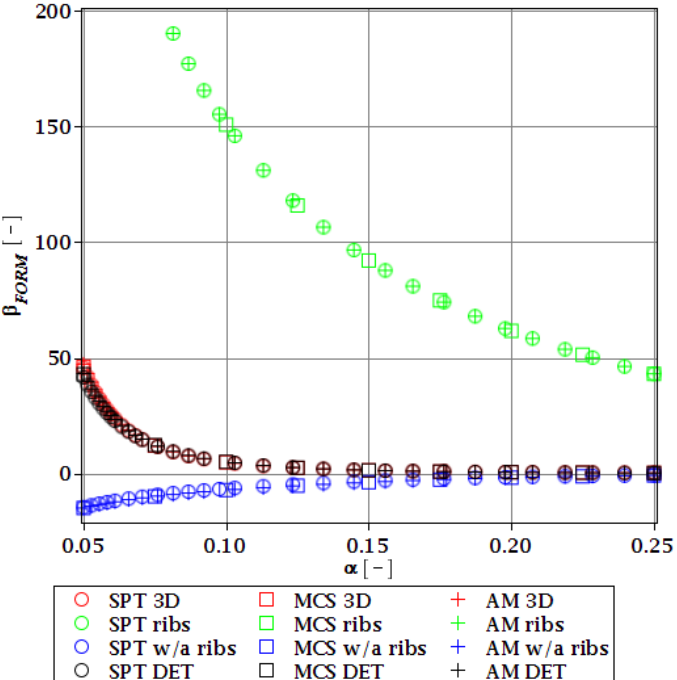
Figure 19. Reliability index of the corrugated I-beam for three ABAQUS models according to FORM and based on the ultimate normal stress.